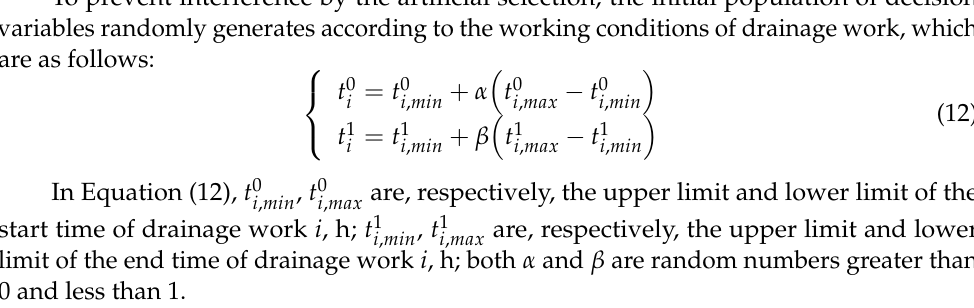
Figure 3. Step diagram of genetic algorithm optimization solution.